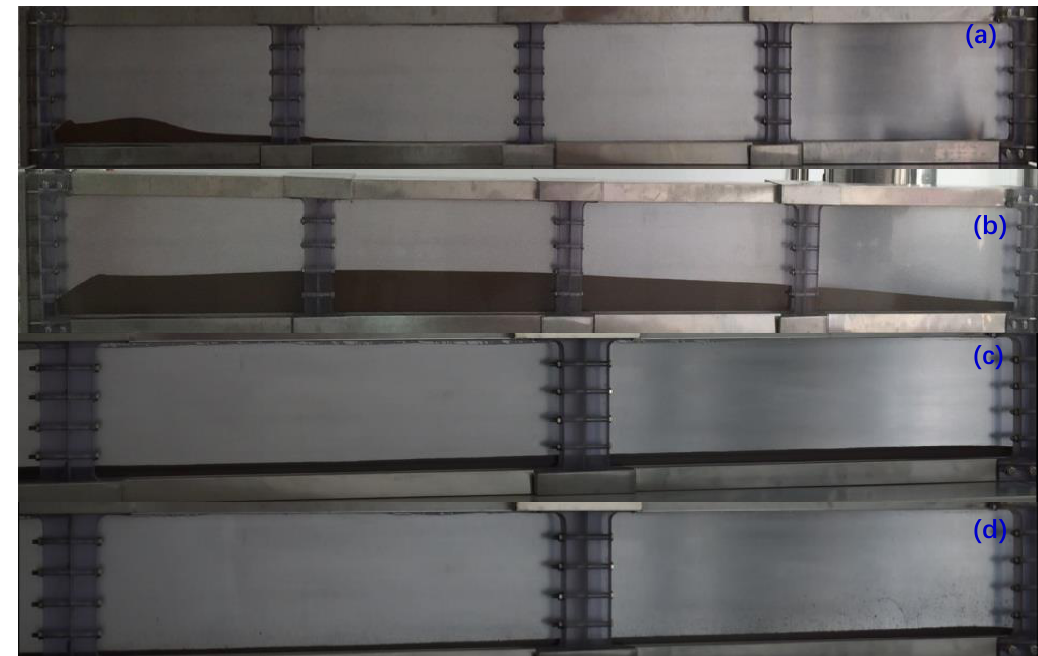
Figure 16. The diagram for proppant placement: ( a ) 20 / 40 mesh proppant in water; ( b ) 20 / 40 mesh proppant in 0.3 wt% hydroxypropyl guar gum (HPG) solution; ( c ) 20 / 40 mesh proppant in 0.3 wt% HELV solution; ( d ) 30 / 50 mesh proppant in 0.3 wt% HELV solution.